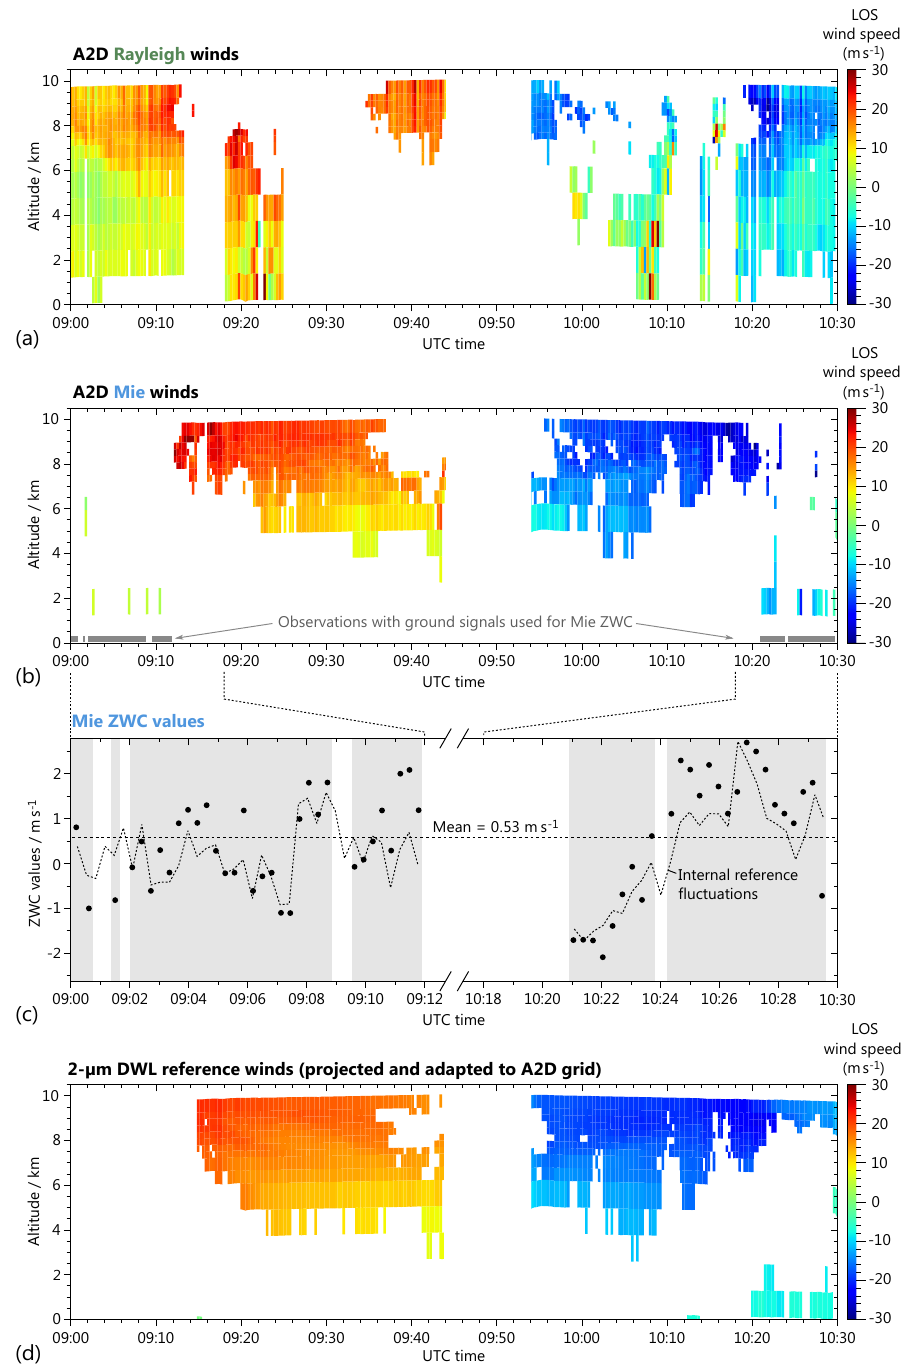
Figure 11. LOS wind profiles (positive towards the instrument) measured during the flight on 4 October 2016 between 09:00 and 10:30UTC using (a) the A2D Rayleigh channel and (b) the A2D Mie channel. The grey boxes indicate periods during which the ground visibility was sufficient for obtaining ZWC data. The corresponding ZWC values are plotted in panel (c) together with the ground speed variations introduced by the Mie response fluctuations in the internal reference signals (see text). (d) Wind curtain measured with the coherent 2µm reference wind lidar. For better comparison, the 2µm wind data were adapted to the measurement grid of the A2D. The data gap between 09:44 and 09:54UTC is due to an interruption of the wind measurement during a curve